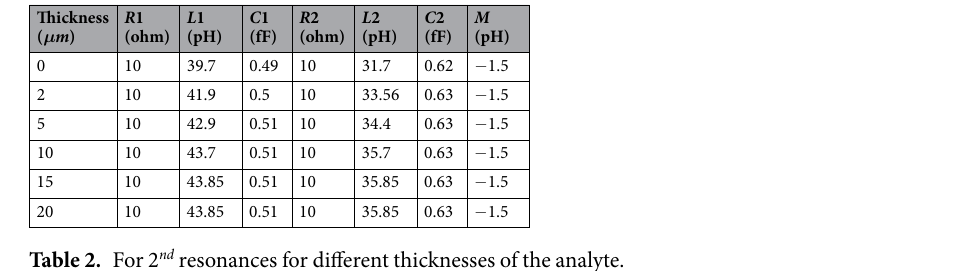
Table 2. For 2 nd resonances for different thicknesses of the